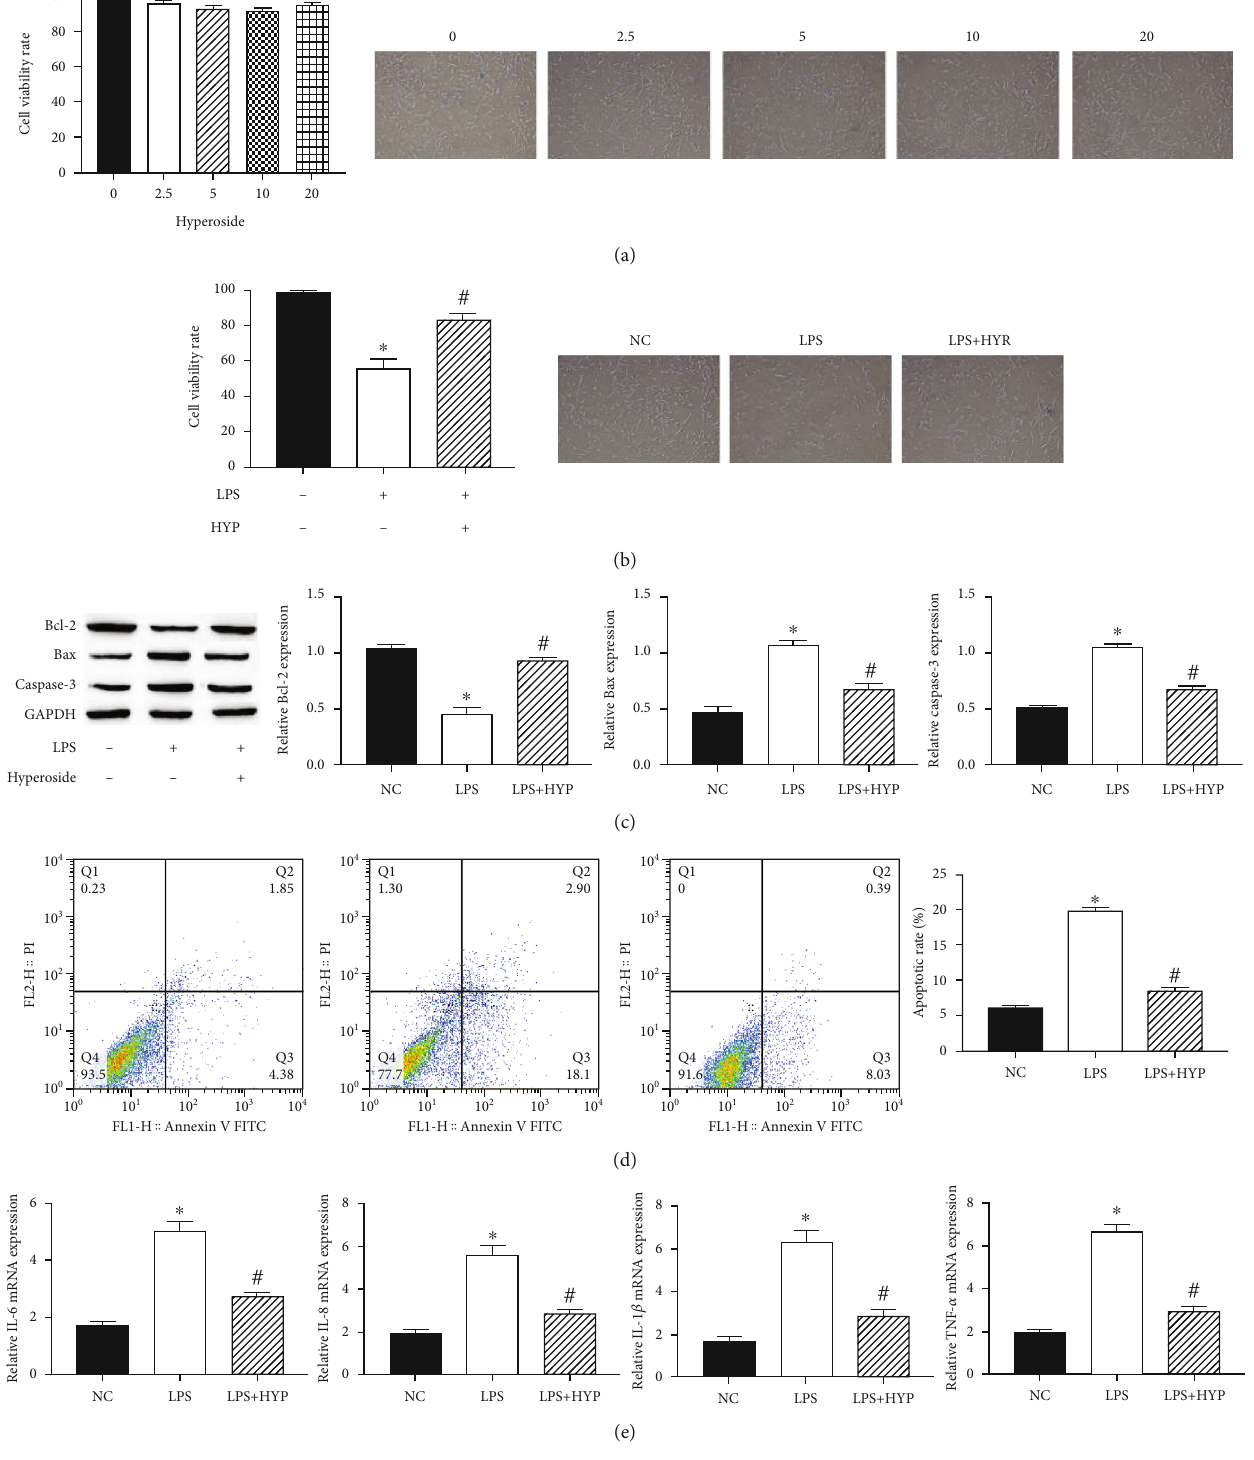
Figure 1: Hyperoside alleviated apoptosis and in fl ammation in the LPS-induced HT22 cells. HT22 cell viability was measured by the MTT assay. Cell viability was observed by a microscope (100x) (a, b). The expression of Bcl-2, Bax, and caspase-3 in HT22 cells was measured by western blotting (c). The HT22 cell apoptosis rate was measured by fl ow cytometry assay (d). The levels of IL-1 β , IL-6, IL-8, and TNF- α mRNA in HT22 cells were measured by qRT-PCR (e); ∗ was considered signi fi cant compared to control ( ∗ P < 0 : 05 ); # was considered signi fi cant compared to LPS ( # P < 0 : 05